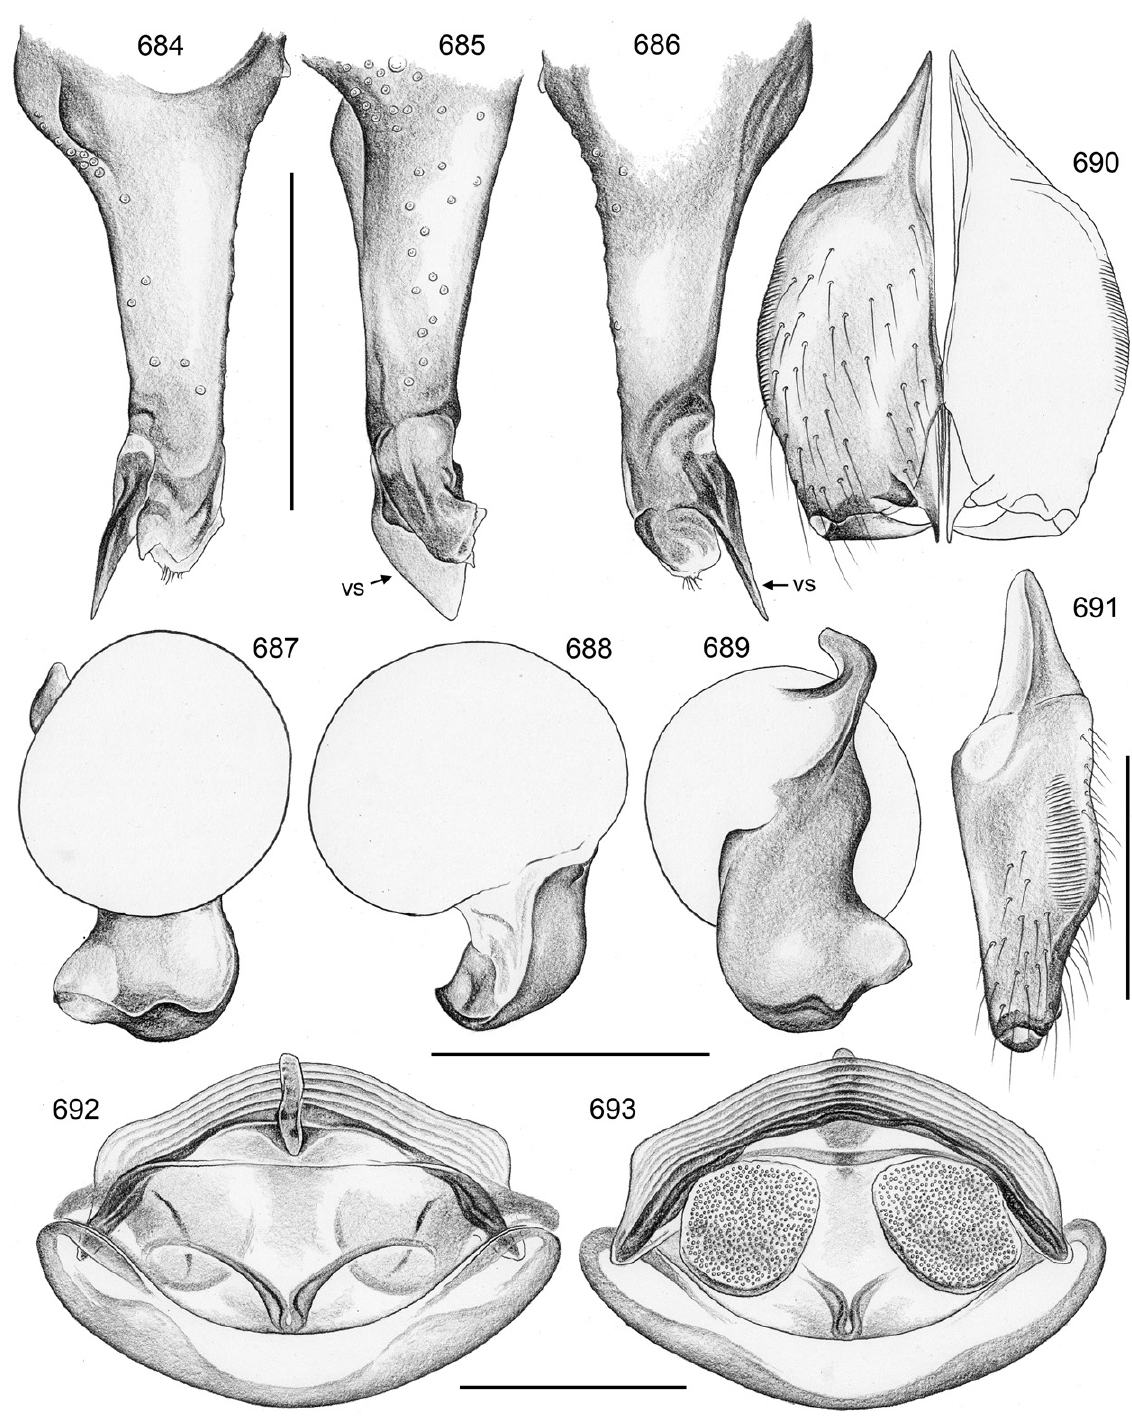
Figs 684–693. Crossopriza malegaon sp. nov.; holotype male, and female from India, 17 mi NE of Malegaon (CAS). 684–686 . Left procursus, prolateral, dorsal, and retrolateral views. 687–689 . Left genital bulb, prolateral, dorsal, and retrolateral views. 690–691 . Male chelicerae, frontal and lateral views. 692–693 . Cleared female genitalia, ventral and dorsal views. Abbreviation: vs = ventral sclerite. Scale bars = 0.3